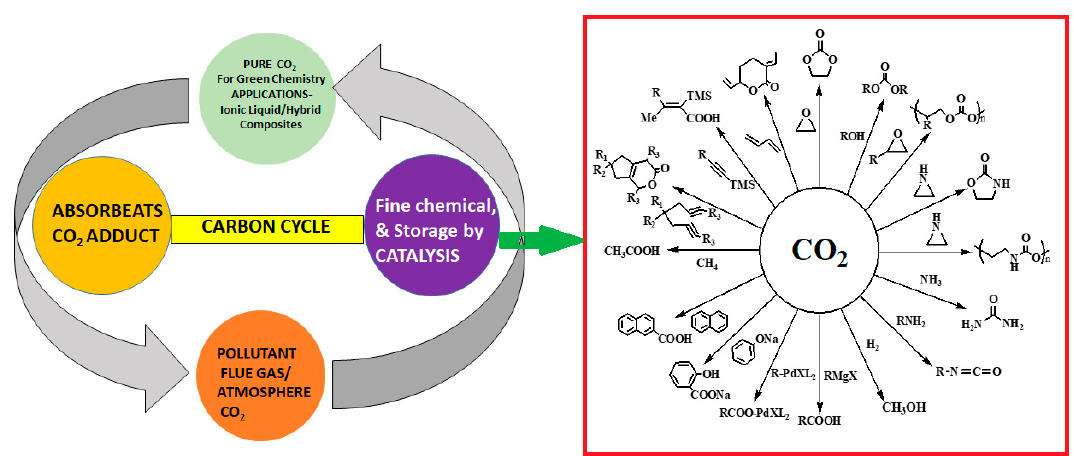
Figure 1. Schematic of carbon cycle for CO 2 , recycle Storage and greenhouse gas utilization for possible fine chemicals production.